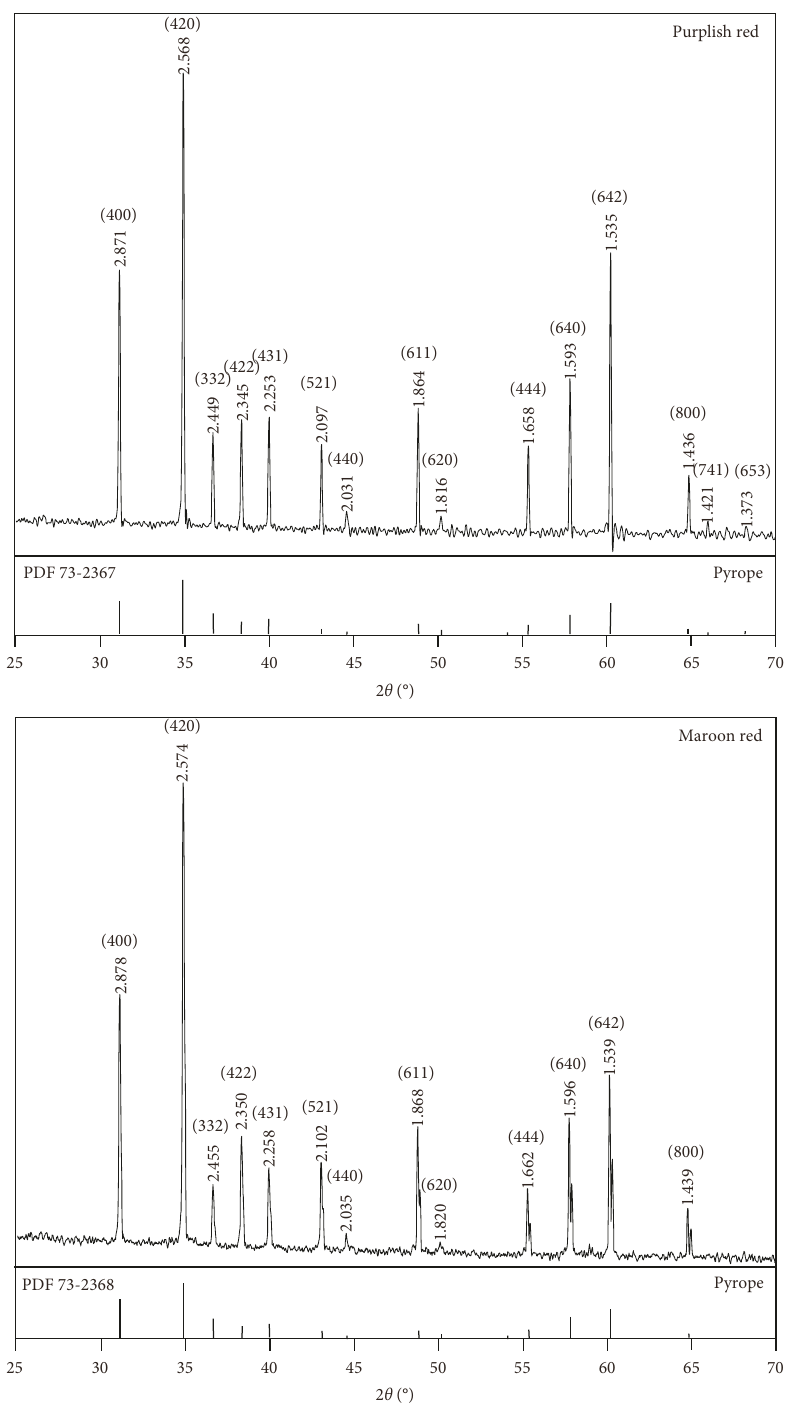
Figure 2: X-Ray powder diffraction spectra of the garnet